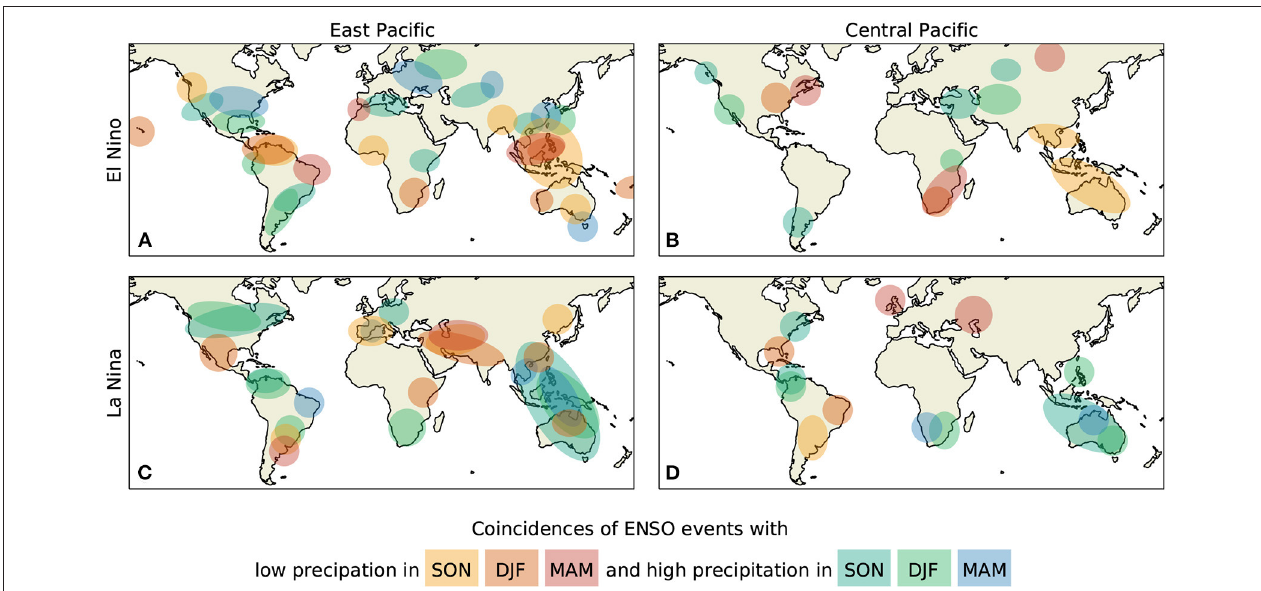
FIGURE 5 | Schematic summary of the results presented in this work. Shaded areas indicate major regions in which very high/low seasonal precipitation sums show significant event coincidence rates with EP (A,C) or CP (B,D) El Niño (A,B) or La Niña phases (C,D)